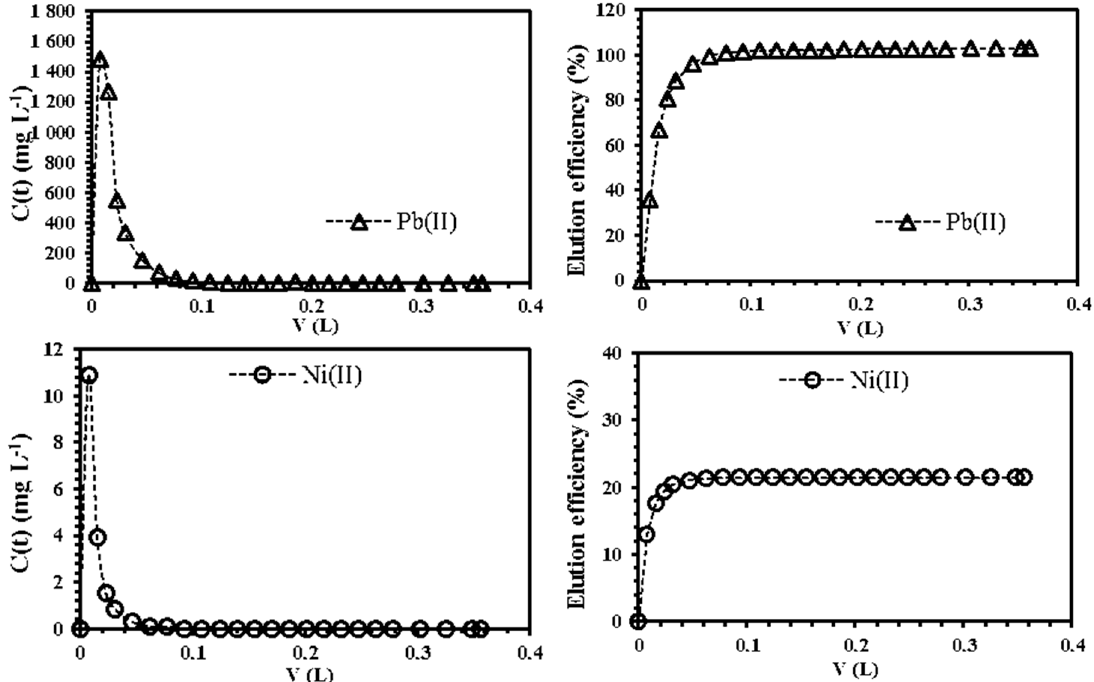
Figure 7. Simultaneous elution of Pb(II) and Ni(II) from the fixed-bed column by using HNO 3 (0.5 M) as eluent ( Left side : Recovered metal concentration as a function of the volume (L), dashed line: desorption trend; right side : Elution efficiency as a function of the volume (L); T : 20 ◦ C; internal diameter of the column, Ø: 0.5 cm; column height: 20 cm; flow rate: 0.13 mL min − 1